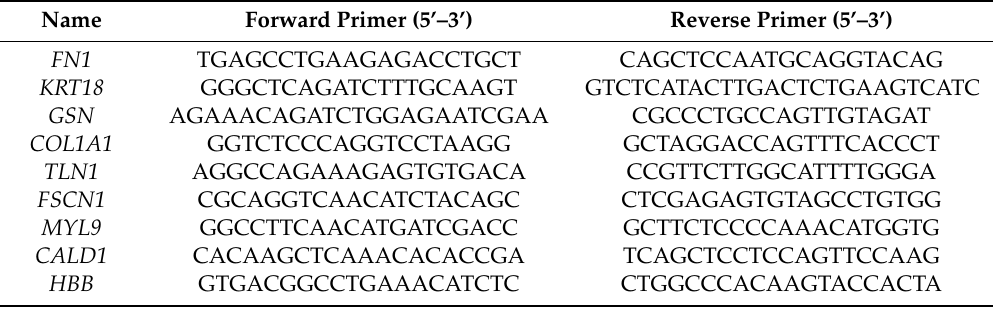
Table 1. Sequences of primers used for the real-time quantitative polymerase chain reaction (RT-qPCR). analysis.